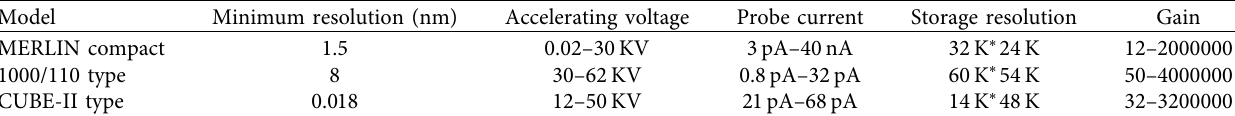
Figure 6: The process of electron beam induction of nanocrystals. Table 1: Related parameters of different brands of microelectronic scanning